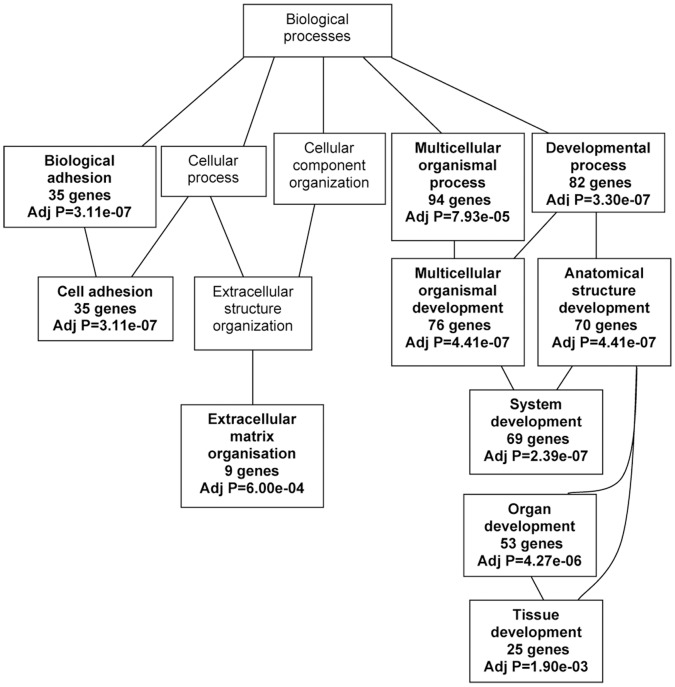
Significant biological processes associated with the differentially expressed genes as identified by Genomatix.The differentially expressed genes in all models of DCIS in comparison to MCF10A were analyzed by WebGestalt2 tool. A Fisher’s exact test was used to determine statistical significance with a significance level of 0.05. The p-values and the number of genes associated with a particular function or process are indicated in bold in the respective boxes.